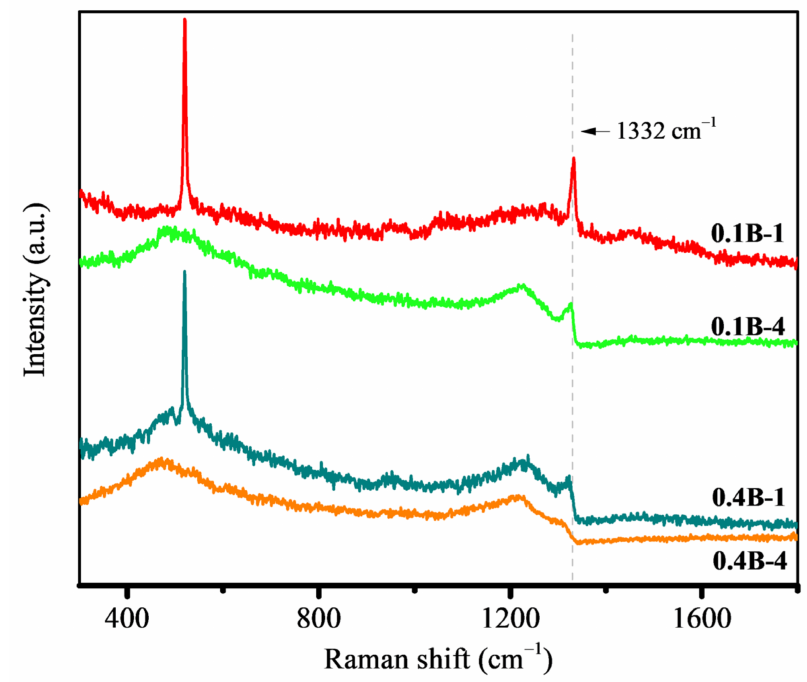
Figure 2. Raman spectra of different BDD